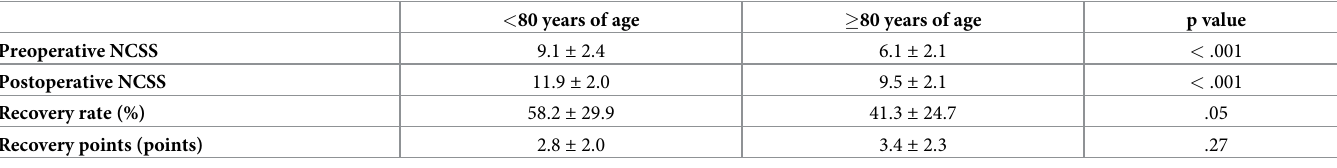
Table 1. Comparisons of the perioperative clinical evaluations between the two patient